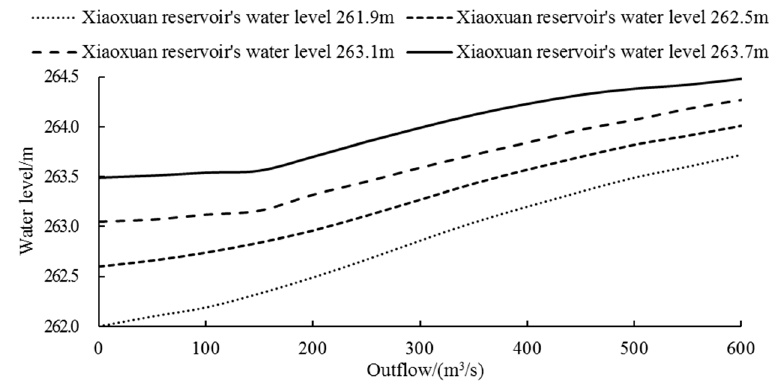
Figure 4. Pankou’s stage-discharge curve.